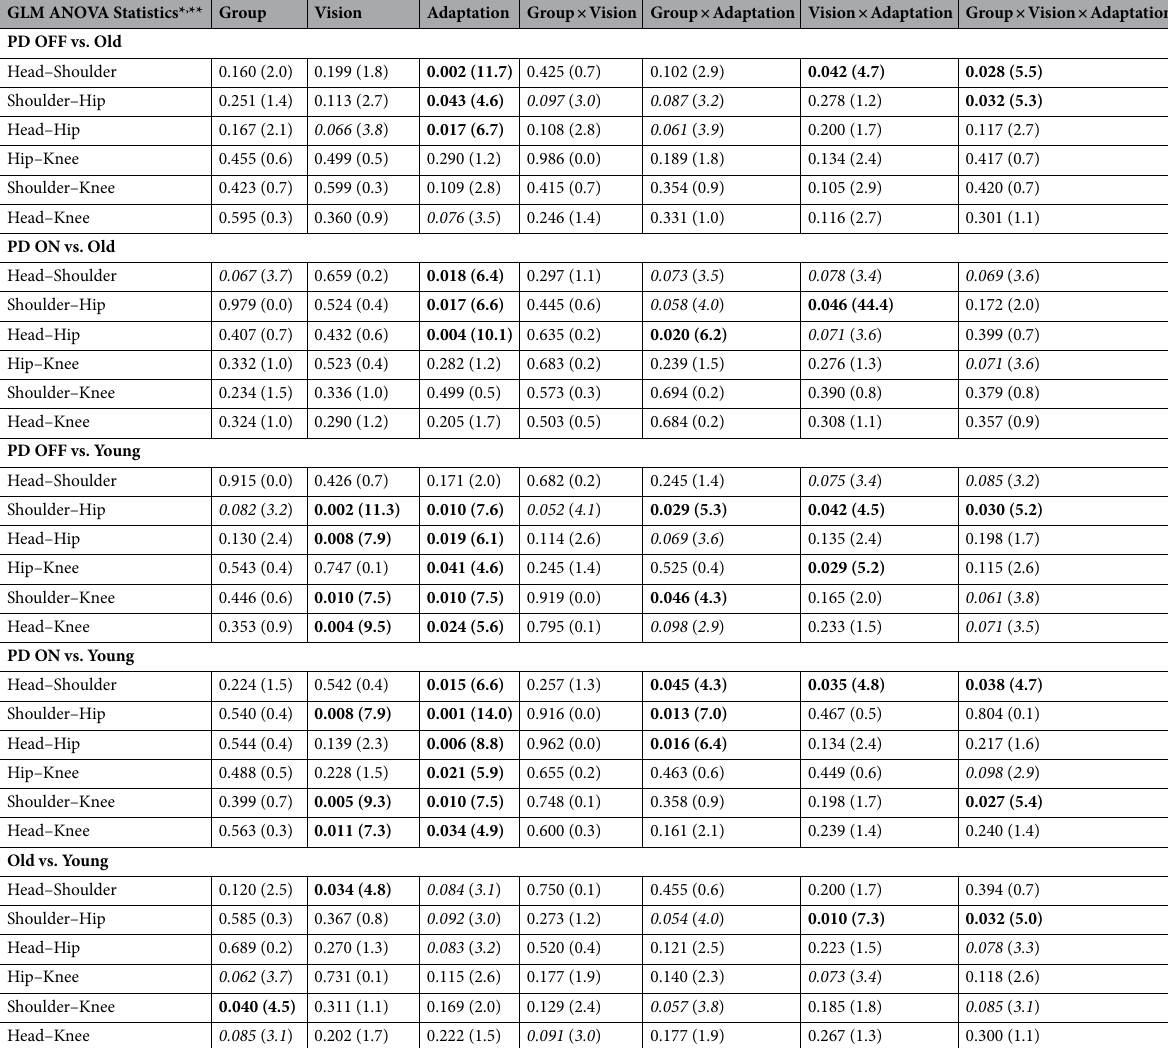
Table 2. Group, vision and adaptation effect on the body movement pattern. *Repeated measures GLM ANOVA of movement patterns with main factors “Group”, “Vision” and “Adaptation” and their factor interactions. **Significant differences are marked with bold numbers and trends (p < 0.1) are marked with italics